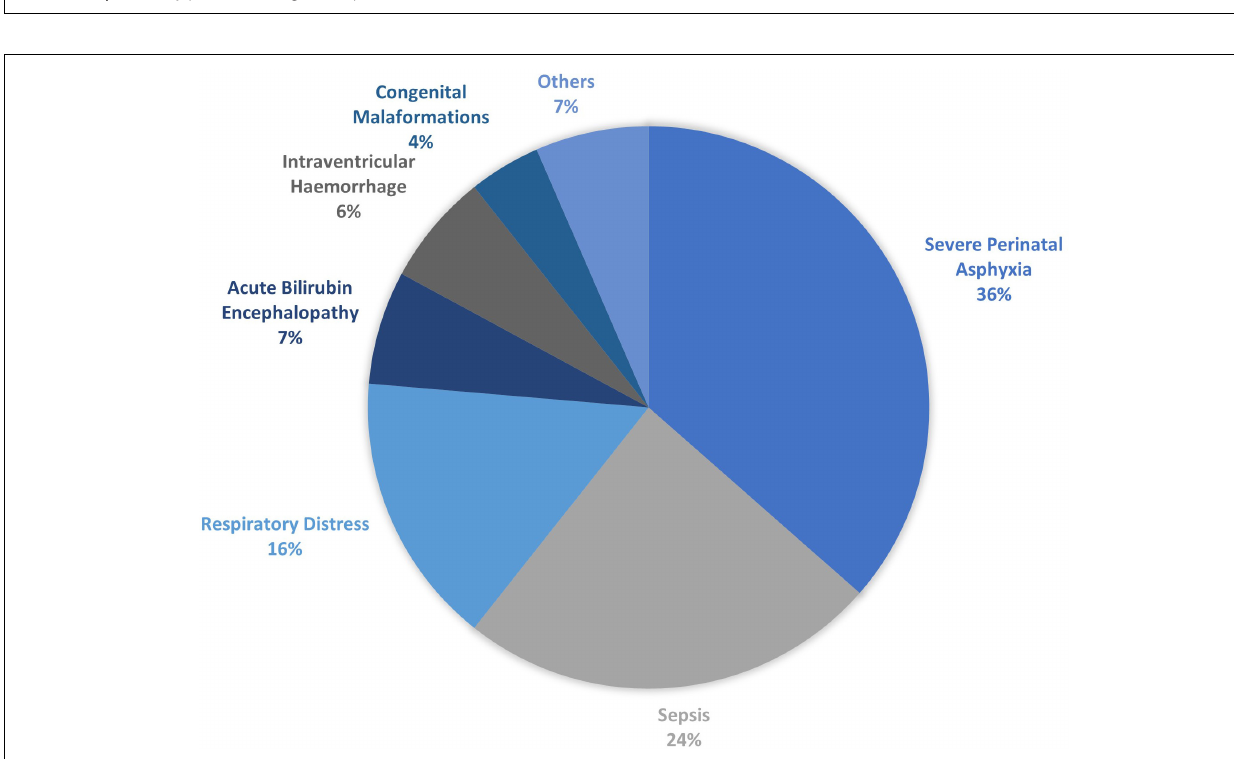
FIGURE 4 | Morbidity pattern among 4,938 preterm babies.